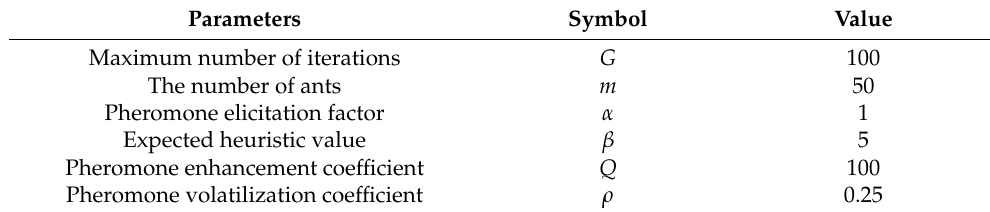
Table 1. ACA parameter